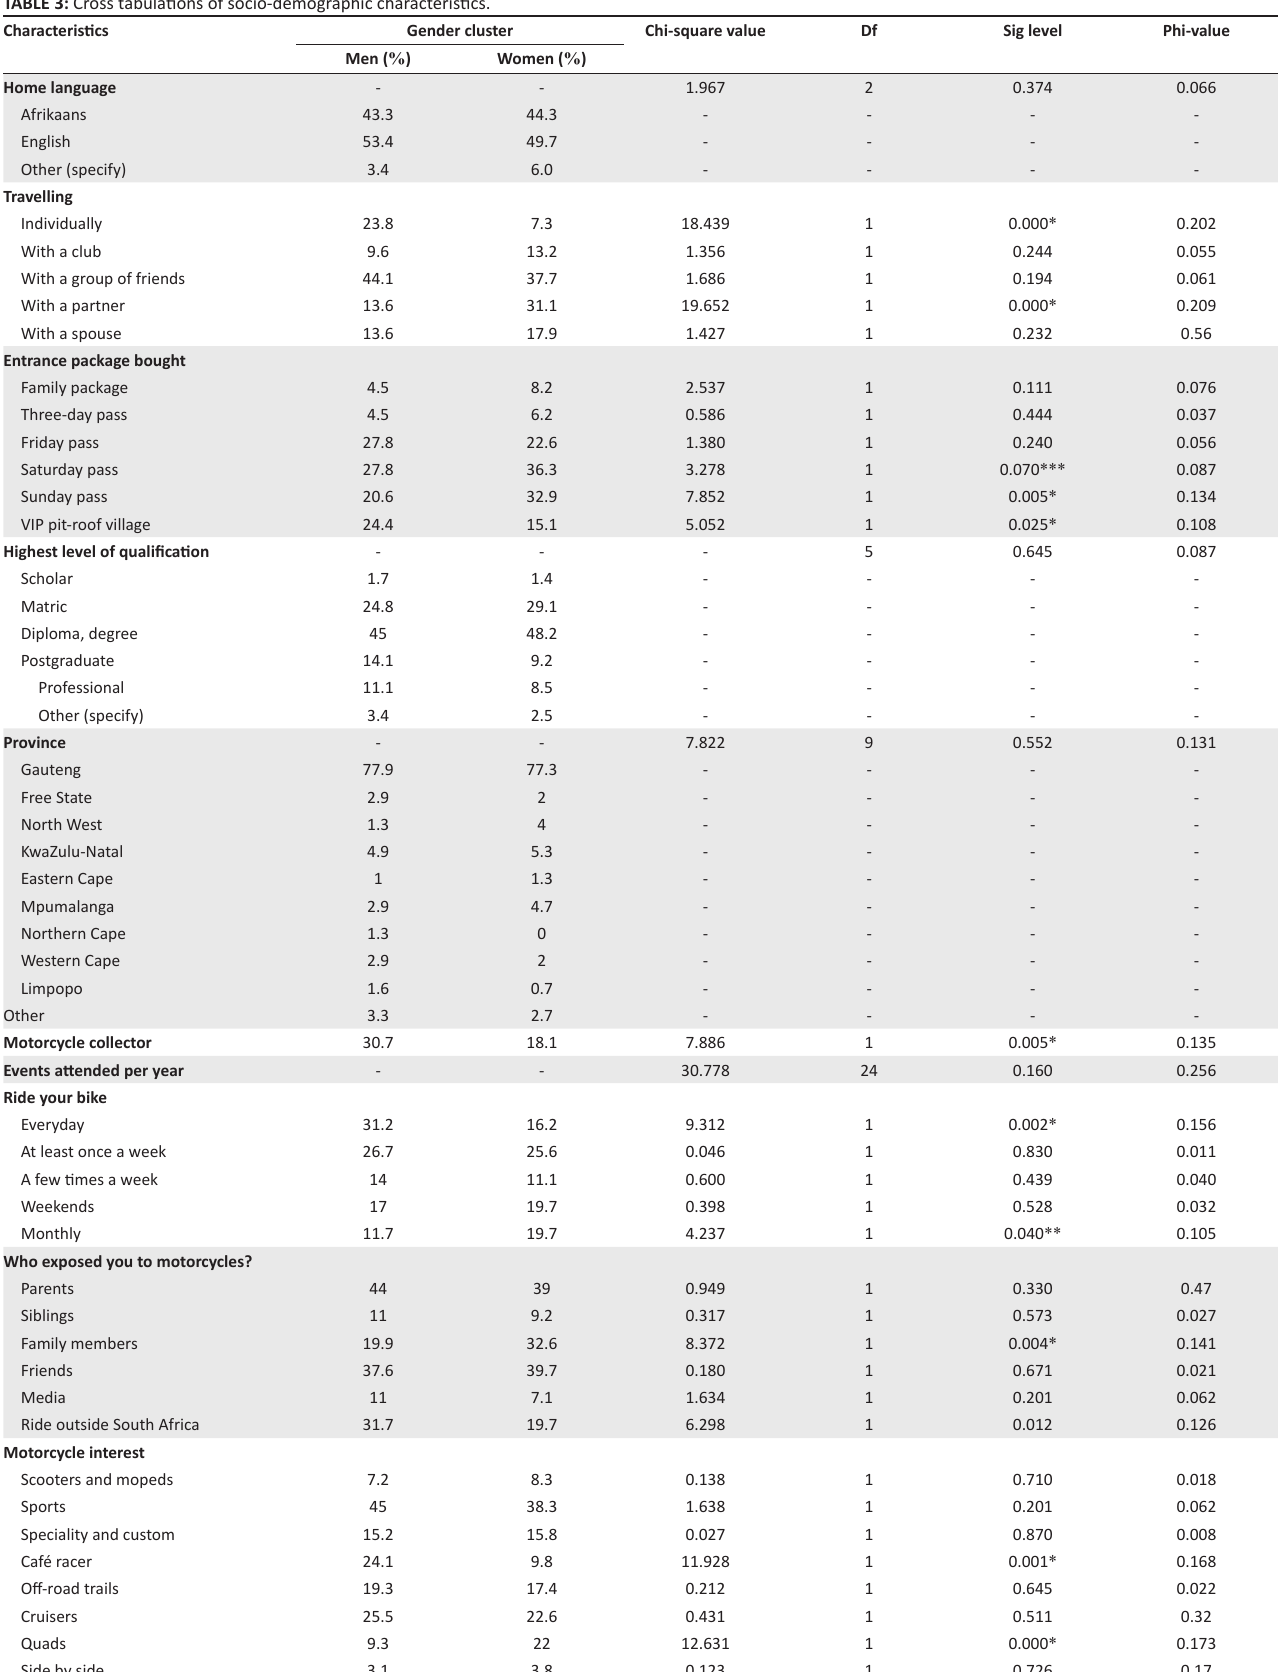
TABLE 3: Cross tabulations of socio-demographic characteristics.